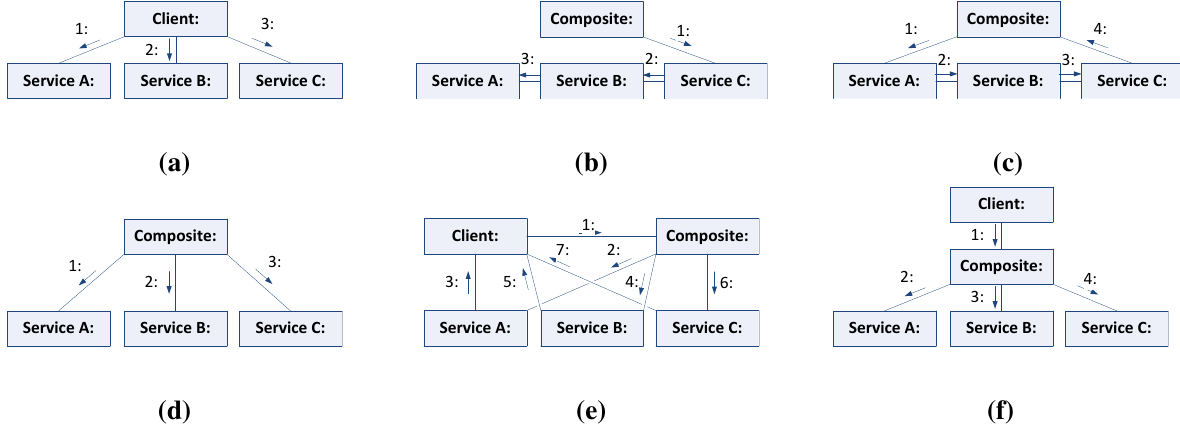
Figure 7. Patterns for designing the control flow of the execution of a service chain ( a – c ) and patterns for adjusting the transparency and control that a human user interacting with a client has regarding a service chain ( d – f ). ( a ) Mediated control flow; ( b ) nested pull control flow; ( c ) nested push control flow; ( d ) transparent chaining; ( e ) translucent chaining; ( f ) opaque